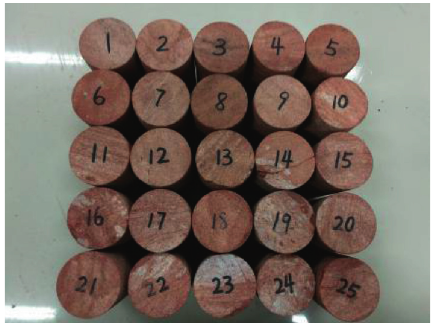
Figure 2: Standardized specimens of the red